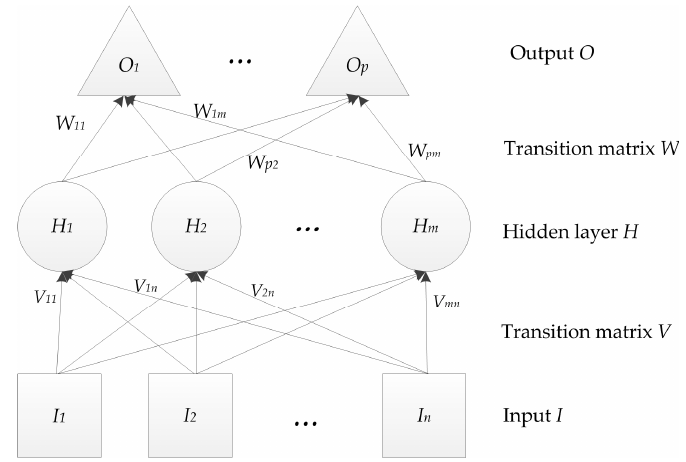
Figure 2. One structure of a multiple-layer feedforward neural network (MLFFN) (adapted from [33]).